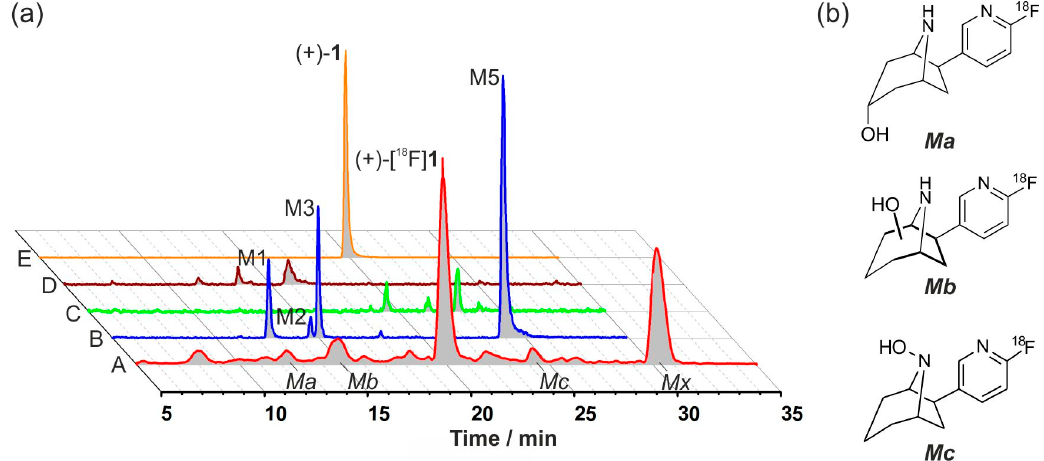
Figure 12. Identification of radiometabolites: ( a ) Aligned radio-HPLC and LC-MS chromatograms (method II). A, radioactivity signal: (+)-[ 18 F] 1 in mouse (plasma, 30 min p.i.); and multi reaction monitoring (MRM) chromatograms ( m/z parent/product ion) after incubation of (+)- 1 with mouse liver microsomes (MLM) (37 °C, 90 min); B, monohydroxylation (223.1/110.0); C, dihydroxylation (239.1/110.0); D, ketone formation (221.1/110.0); and E, (+)- 1 (207.1/110.0). Signal intensities have been adapted; ( b ) Structures of assigned radiometabolites.